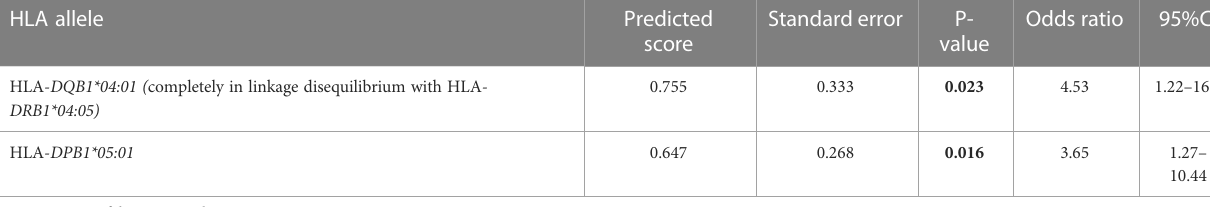
TABLE 2F Multiple logistic regression analysis of HLA-alleles in ICI-T1DM patients and ICI-controls. HLA allele Predicted